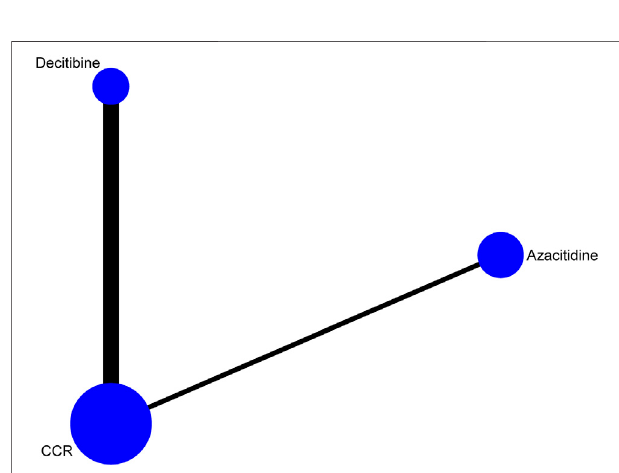
FIGURE 2 | Network of interventional treatments comparing types of acute myeloid leukemia and higher-risk myelodysplastic syndrome (CR). The sizes of the nodes represent the total sample size for each treatment. Line thicknessandthenumbersbesidethelinescorrespondtothenumberof trials. CCR, conventional care